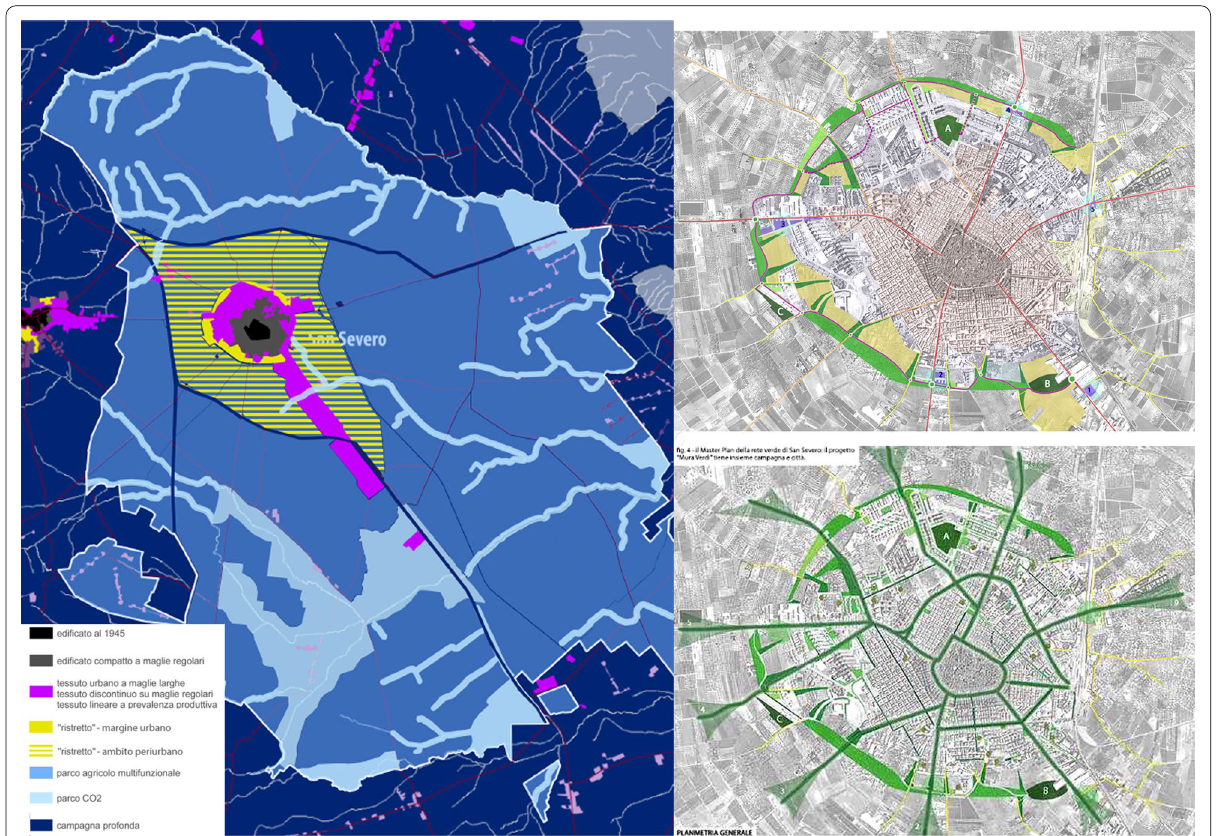
Fig. 3 The strategy of San Severo Mosaic. The image on the left shows the components of the Pact. The strategy identifies the CO2 Park (light blue shape) for forestation in hydrogeological risk areas. In addition, it identifies the urban ‘ ristretto’ (yellow) and the peri-urban ‘ ristretto’ (yellow hatch). The master plan of the urban ‘ ristretto’ shows the relationship between the green belt (top right), linked to the expansion areas, and the ecological corridors (bottom right). Source: Municipality of San Severo, Extracts from tables E1 (original content scale unknow, north–south oriented) and E3(original content scale unknow, north–south oriented) of the Adaptation of the Municipal Plan to the PPTR